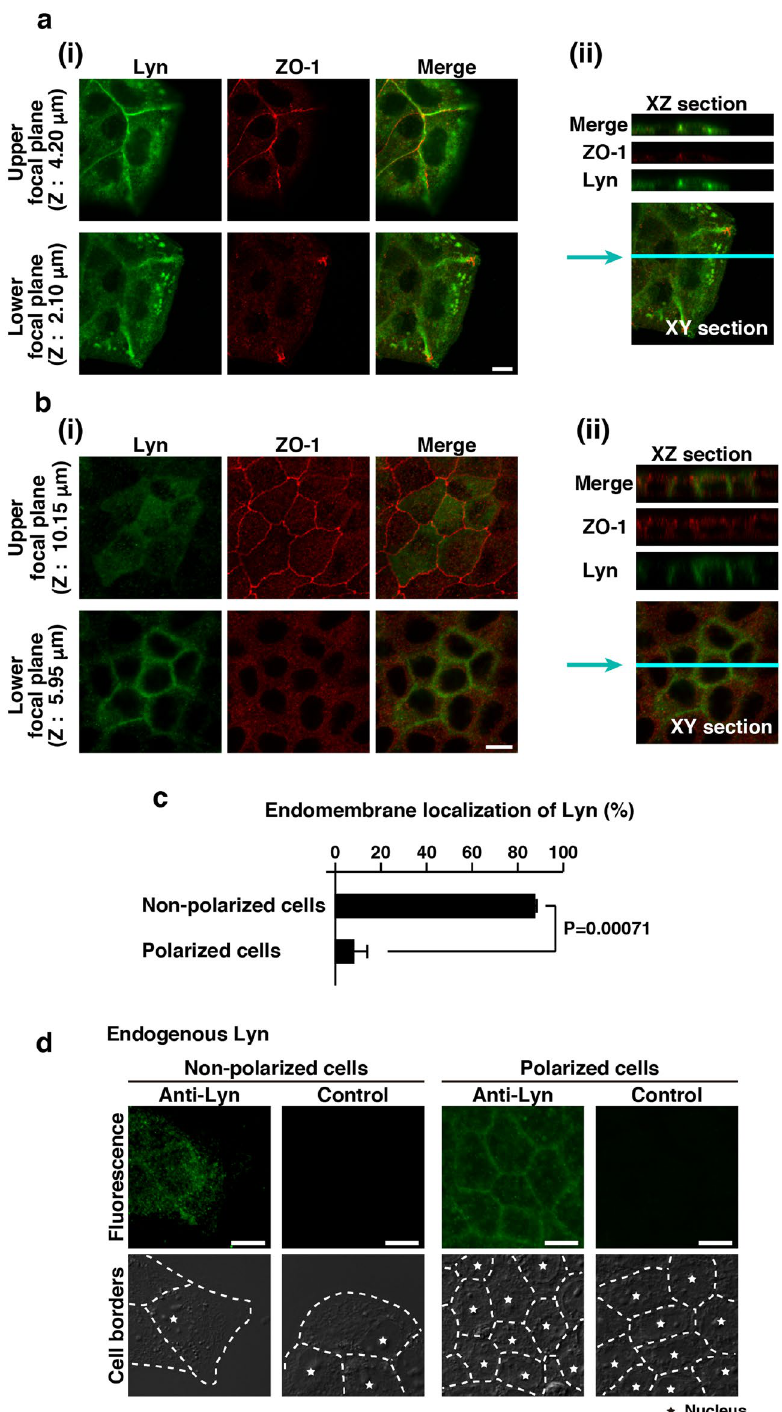
Figure 2. Localizations of Lyn in MDCK cells under the different culture conditions. (a – c) MDCK/TR/Lyn cells grown in sparse (non-polarized) ( a ) or confluent (polarized) ( b ) culture were treated with 1 μ g/ml Dox for 10 h. Cells were fixed and then stained with rabbit polyclonal anti-Lyn antibody (green) and anti-ZO-1 antibody (red). The positions of the focal plane (Upper and Lower) are indicated along the z-axis. Representative XY sections ( i ) and XZ sections on the blue line (ii) are shown. Scale bar, 10 μ m. (c) The number of cells in which Lyn was appreciably accumulated to endomembranes was counted. Cells grown at the cell periphery of each colony were regarded as non-polarized cells. The data represent the mean ratio ± S.D. from three independent experiments in which at least 50 cells for each category were scored. The significant difference is calculated by one-tailed Student’s t test. ( d ) Parental MDCK cells were grown in sparse (non-polarized) or confluent (polarized) culture. Cells were fixed and stained with rabbit polyclonal anti-Lyn antibody. Control samples were stained with secondary antibody alone. For eye guide, cell borders and nuclei are marked by dotted lines and stars, respectively. Scale bar, 10 μ